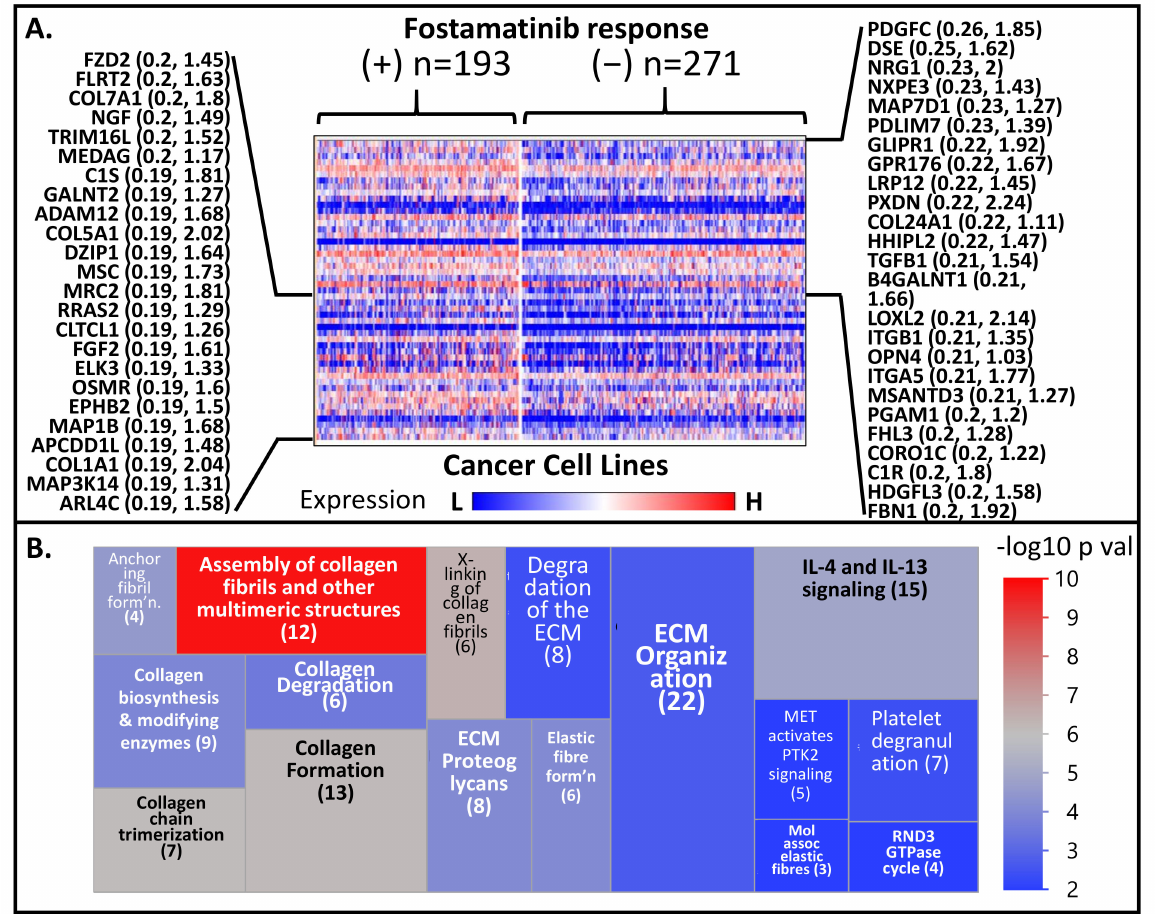
Figure 5. ( A ) Comparative heat map of expression of genes between relatively responsive (+) and non-responsive (–) against the serine-threonine kinase inhibitor fostamatinib. Only the genes with the highest signal-to-noise ratio (responsive vs. non-responsive) are shown. ( B ) A treemap representation of the Reactome pathways resulted when the top 150 PrCa metastasis-upregulated genes were used in the Reactome analysis. Only the top 16 pathways (the ones with the lowest Entities p values) are